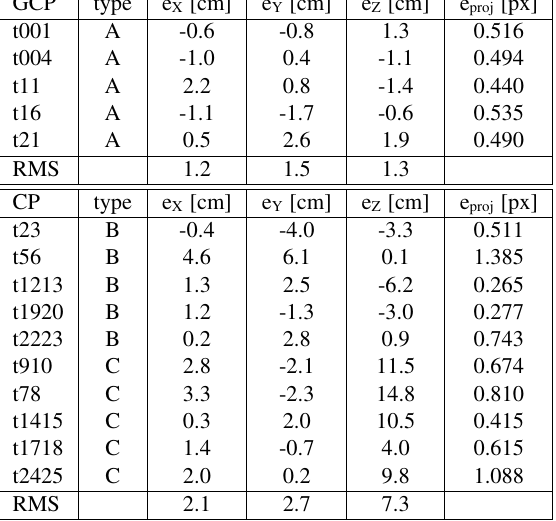
Table 2. High-contrast target as GCPs, errors on GCPs and CPs